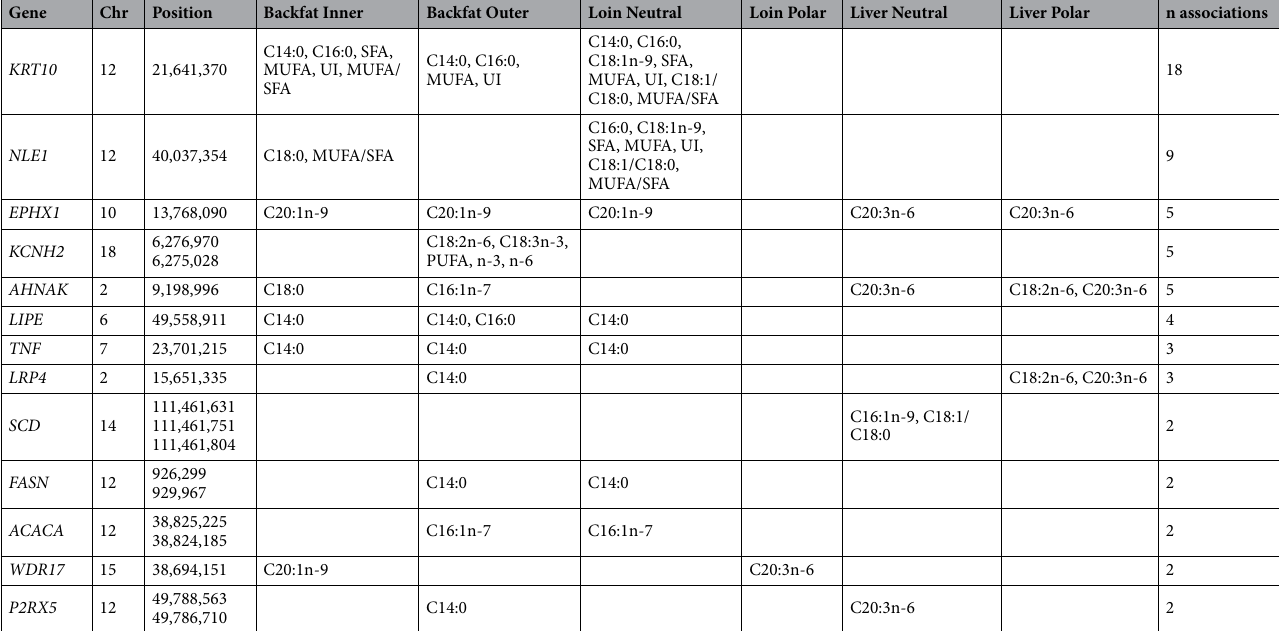
Table 4. Significant association results for FA composition traits, including SNPs with at least two significant effects on different traits or different tissues (q <